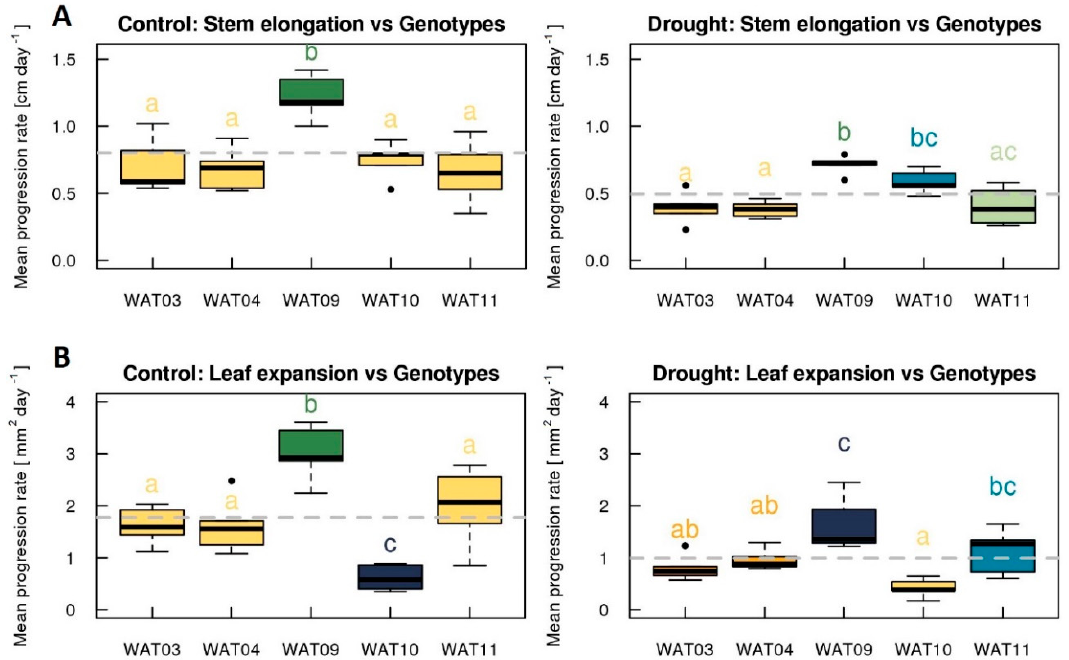
Figure 3. Mean stem elongation rate ( A ) and leaf expansion rate ( B ) of five miscanthus genotypes with varying dry biomass under control (left) and drought stress (right) treatments; significant differences between genotypes are based on Tukey multiple comparison test and denoted by lettering above the boxes (conf. level = 0.95); each statistical group is drawn with the same colour; grey horizontal, dashed, line is showing the populations average; outliers (which exceeded 2.5 standard deviations) are plotted as individual points.